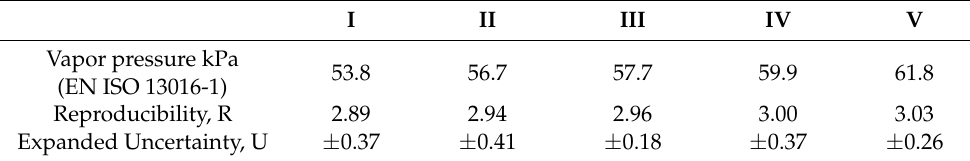
Table 5. Average values of vapor pressure for base fuels and expanded uncertainties.